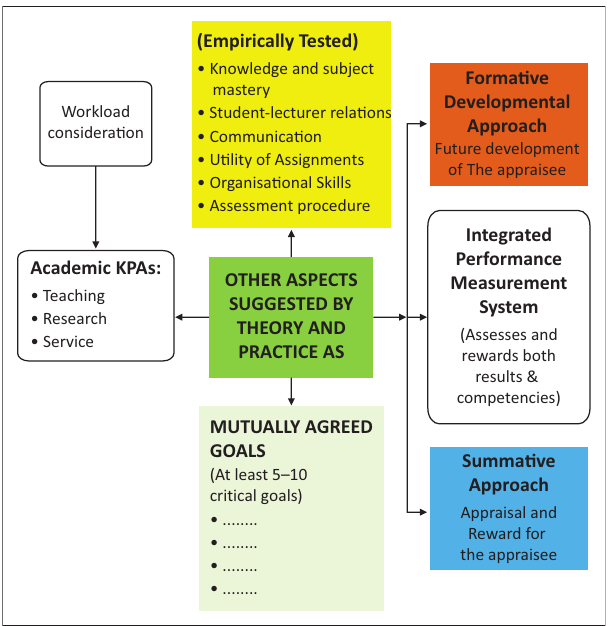
FIGURE 1: Conceptual model of performance measurement for